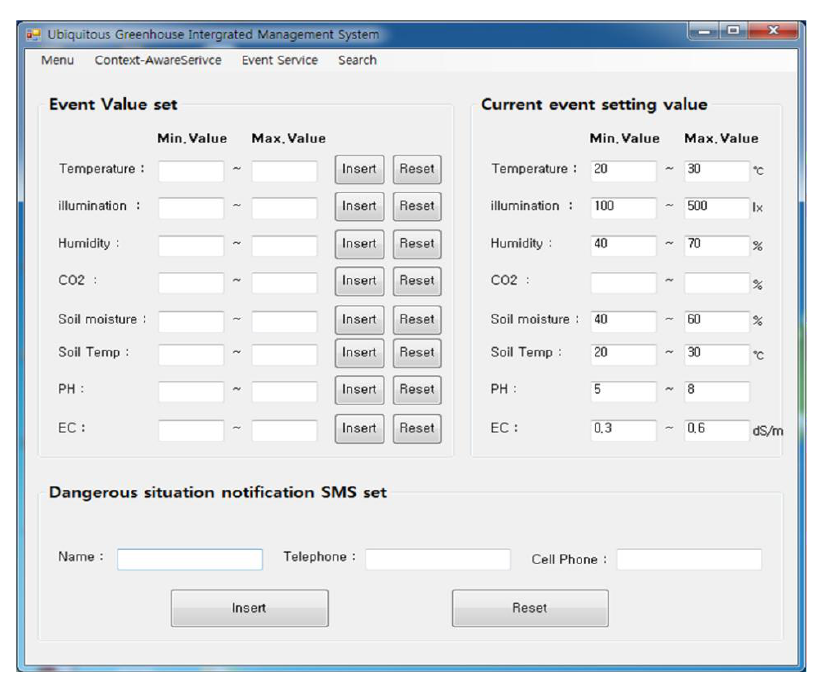
Figure 18. Event service GUI.